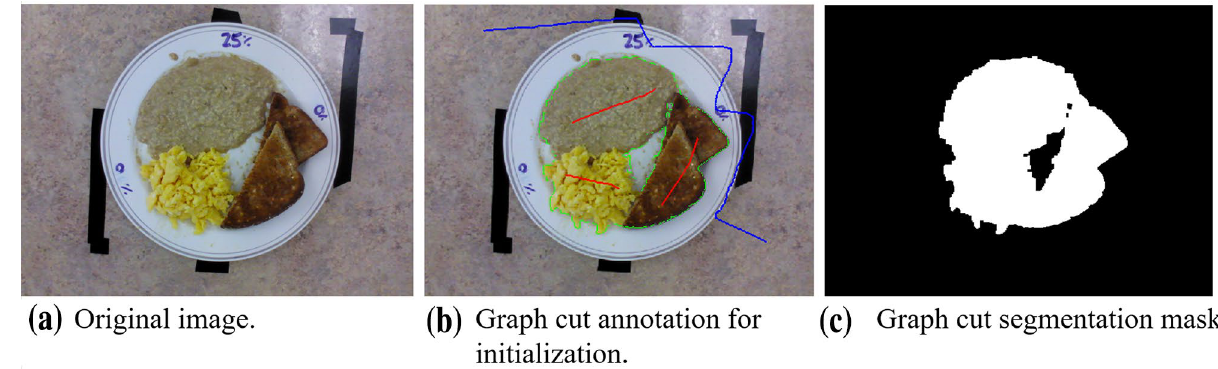
Figure 6. Sample graph cuts annotation with one line per food item (red) and one background line (blue) and resulting segmentation